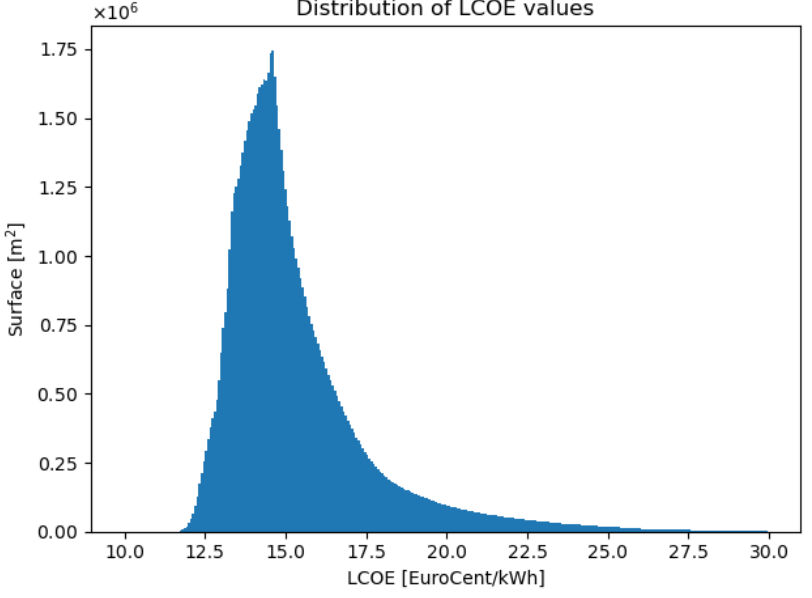
Figure 12. Distribution of the levelized cost of electricity for all the rooftop surfaces in Sardinia.